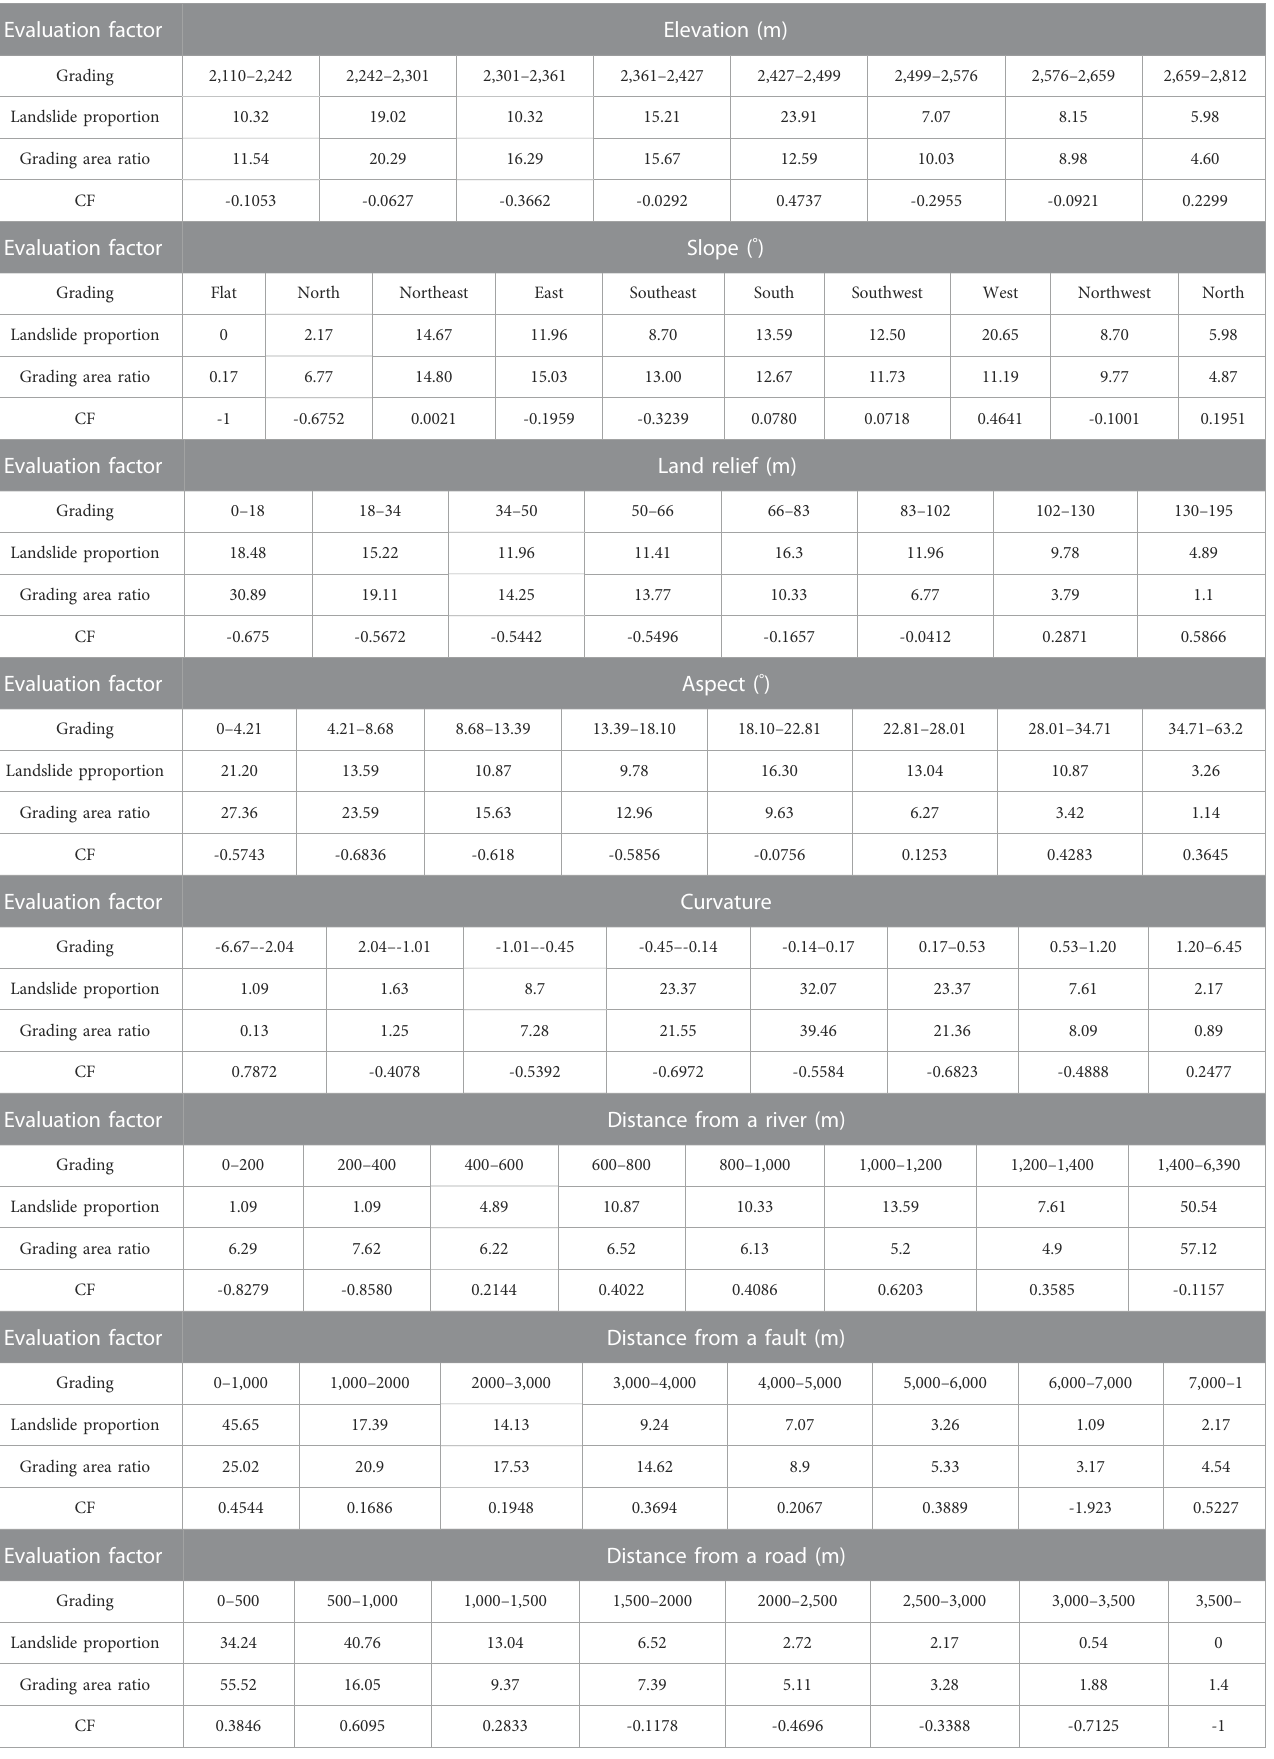
TABLE 1 Grading of factors and CF